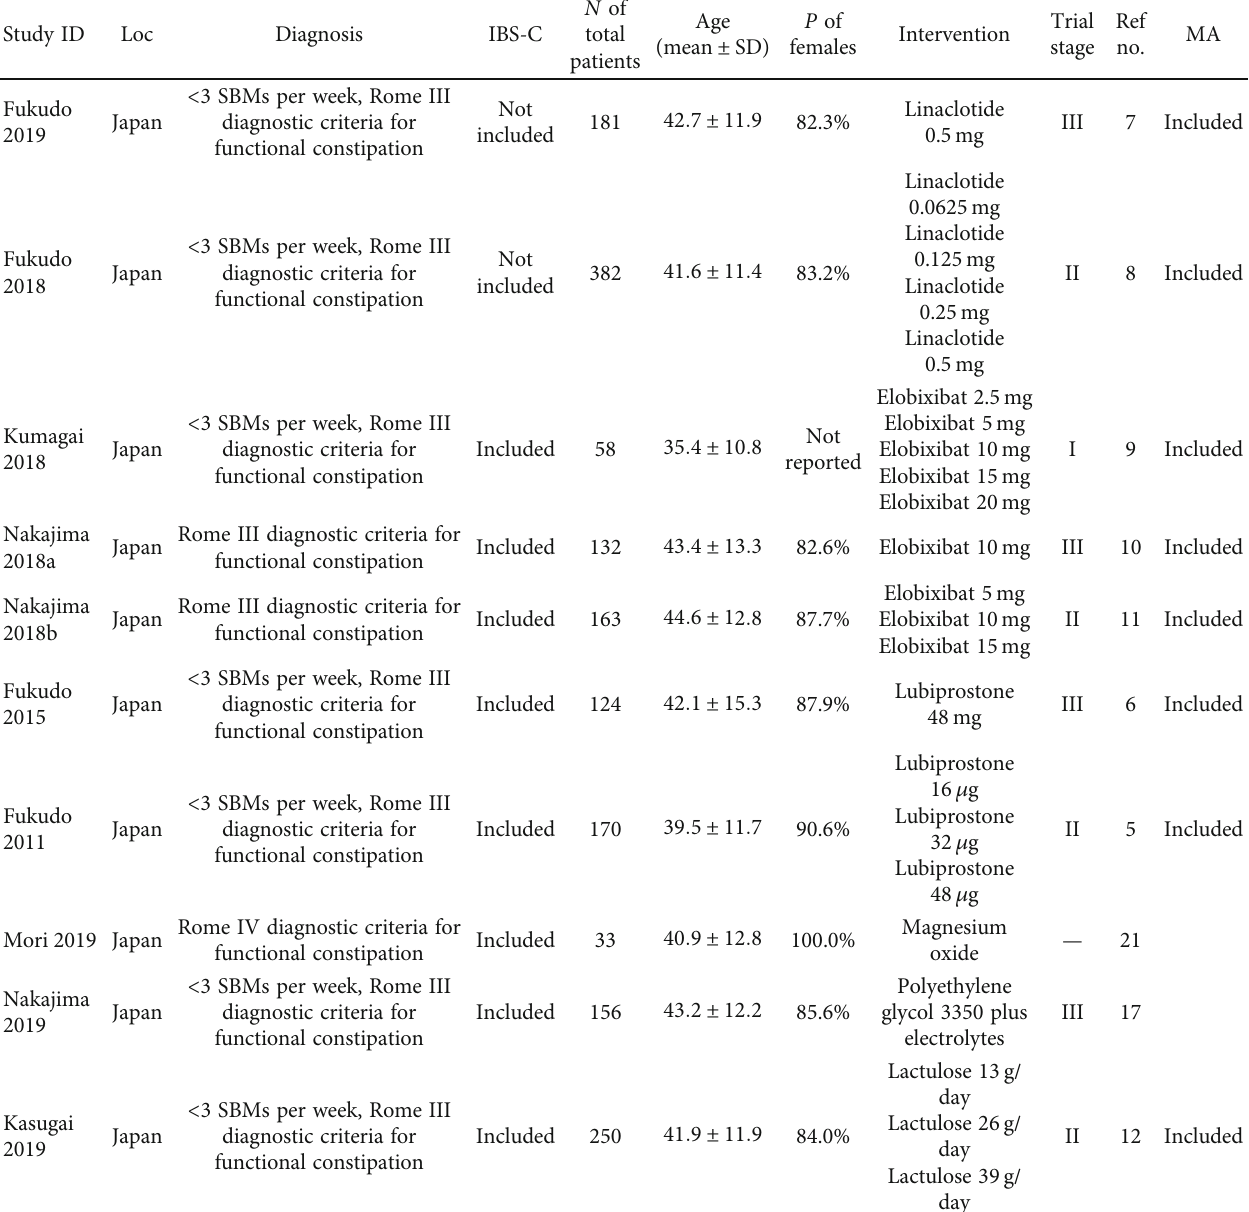
Table 1: All eligible